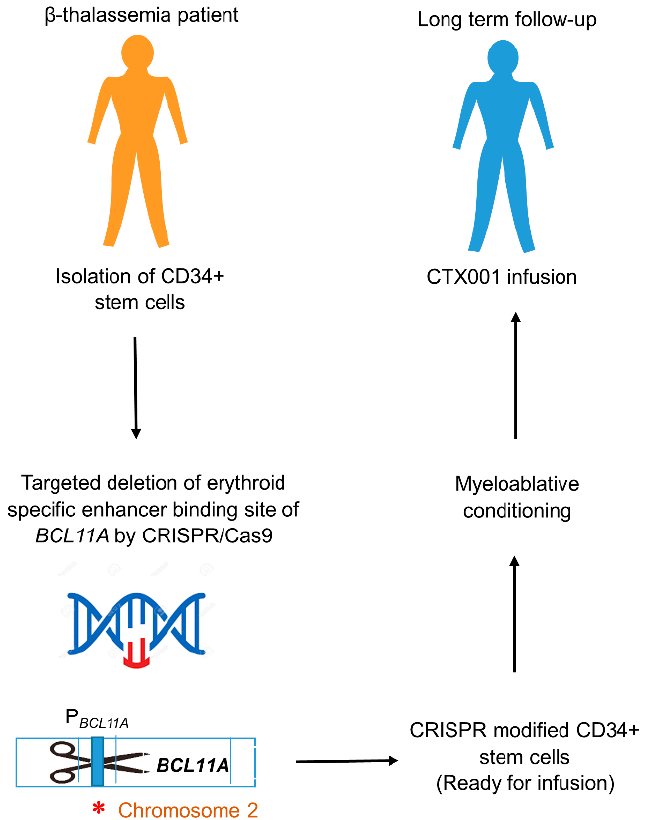
Figure 3. CTX001 therapy workflow. CTX001therapy is a potential one-time gene therapy for TDT and severe SCD that relies on CRISPR/Cas9 gene editing to facilitate the patient’s own cells to produce high levels of HbF. CRISPR/Cas9 system targeting the deletion of erythroid-specific enhancer binding site of BCL11A is introduced into CD34+ stem cells from β -thalassemia patients, resulting in downregulation of BCL11A expression. Subsequent inactivation of BCL11A binding to the P γ -globin causes reactivation of the γ -globin gene, resulting in fetal globin switch. After quality controlling and clinical testing, CRISPR-modified CD34+ stem cells are introduced into β -thalassemia patient via autologous transplantation, along with myeloablative chemotherapy and immune-suppressive treatments [103–105]. P BCL11A ; Promoter region of BCL11A gene. ∗ (Asterisk symbol); Indel mutation introduced by